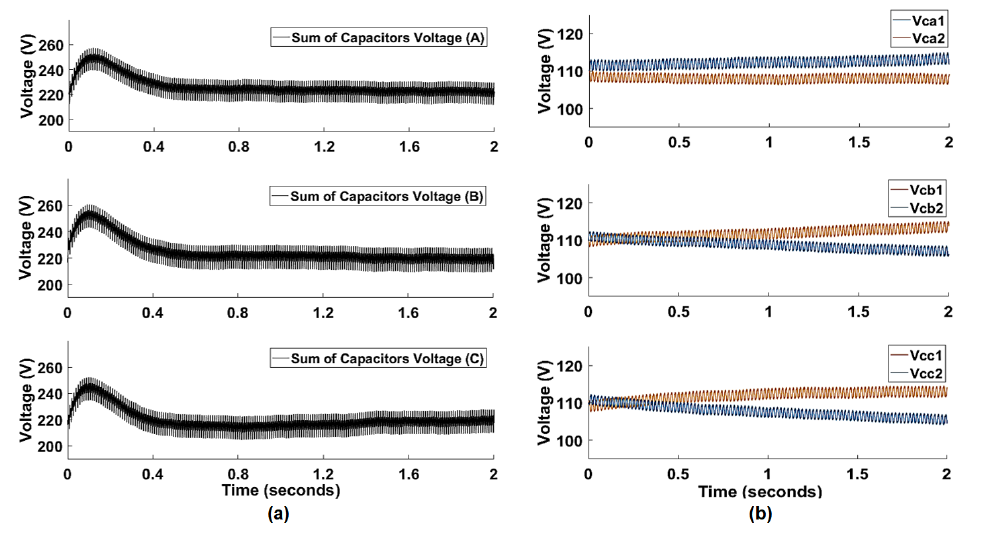
Figure 17. Balanced DC-link capacitors: ( a ) balanced summated DC-link capacitor voltage, ( b ) devia- tion of the DC-link capacitor voltage from its reference value when voltage swapping is disabled.